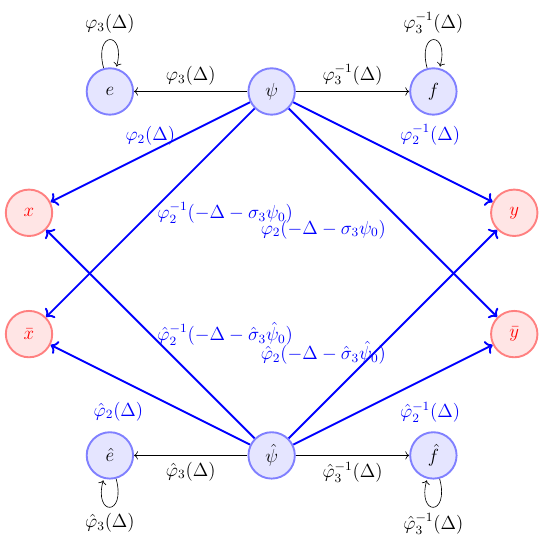
Figure 4 . All generators of algebra from gluing, together with their charges with respect to ( u ) and ^ ( u